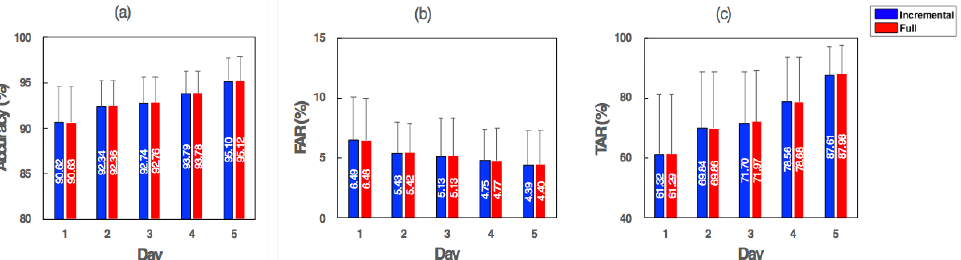
Figure 13. The result of the benchmark test with the incremental learning and full training in terms of ( a ) the accuracy, ( b ) FAR and ( c ) TAR.